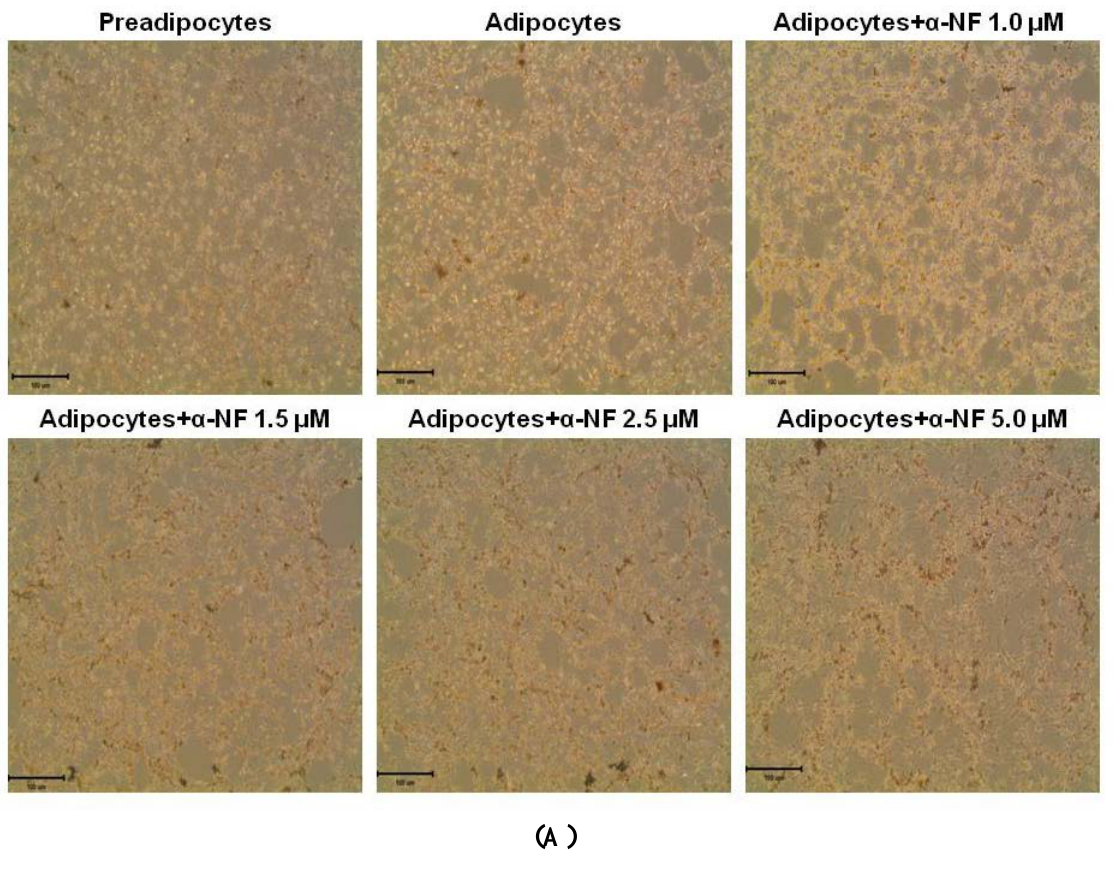
Figure 1. Effect of α-naphthoflavone (α-NF) on cytotoxicity in differentiated adipocytes. Cells were treated with various concentrations of α-NF for 16 h, and cell viability was measured with an 3-(4,5-dimethylthiazol-2-yl)-5-(3-carboxymethoxyphenyl)-2-(4- sulfophenyl)-2H-tetrazolium (MTS) assay kit. Values are the mean ± SD from three measurements. Data with different letters significantly differ ( p <